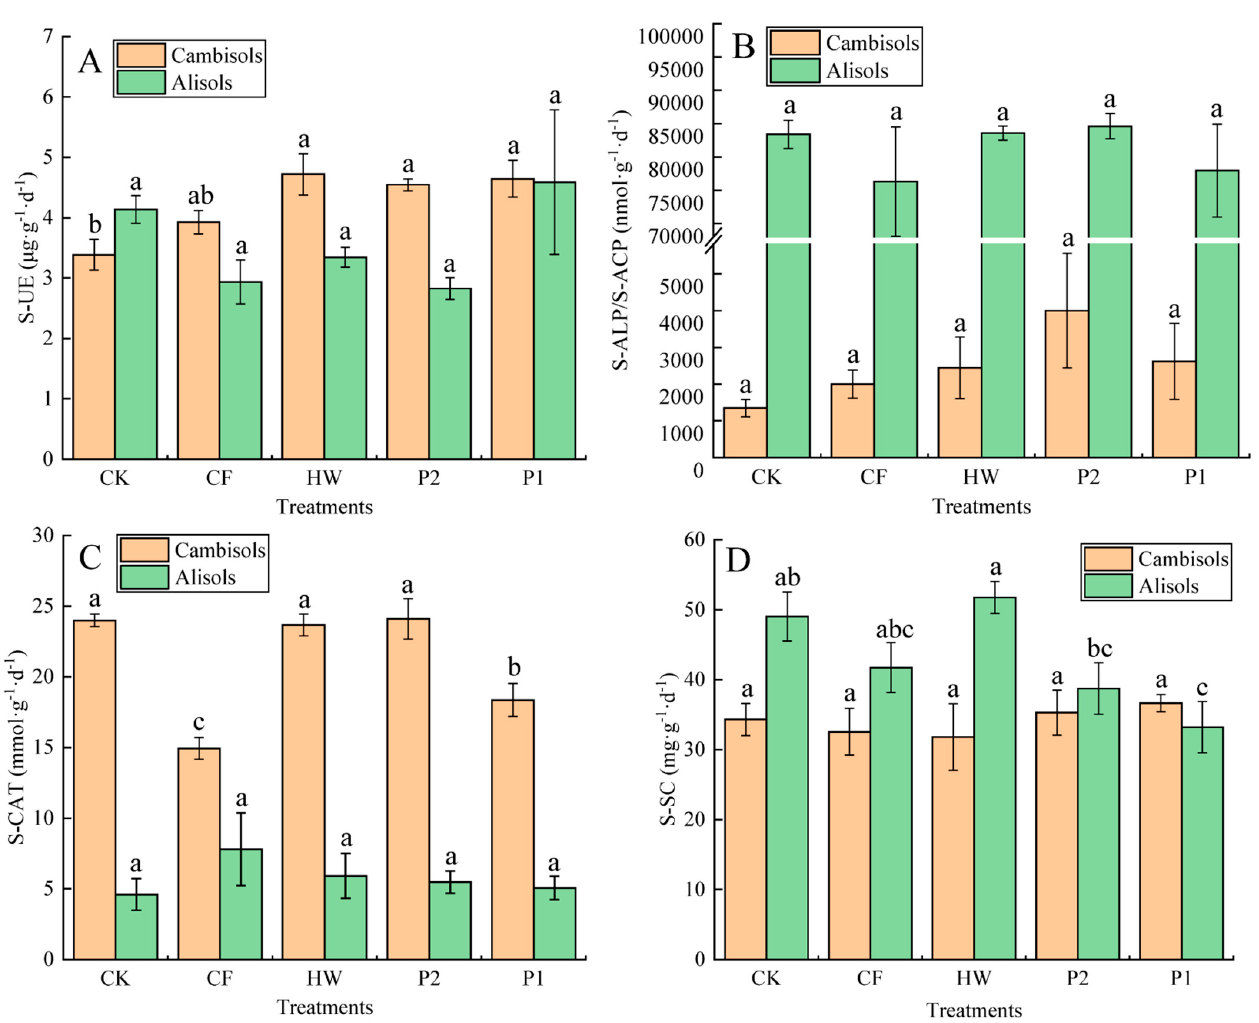
Figure 2. Mean value accompanying the same letter in the same period (N = 3) in Duncan’s multiple range test difference test showed no statistically significant difference ( p = 0.05).